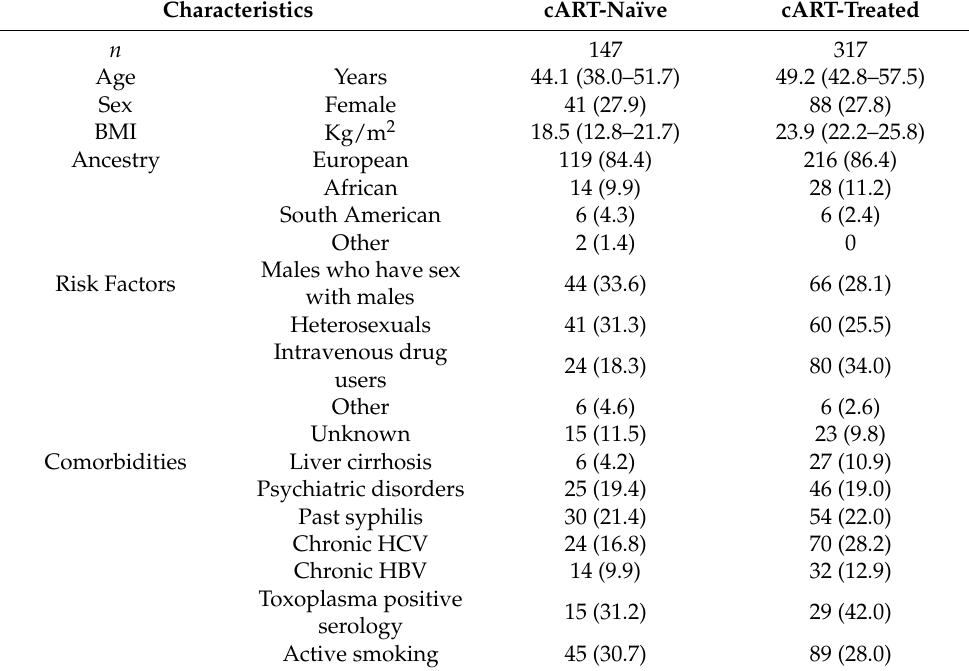
Table 1. Demographic features, risk factors and comorbidities of study